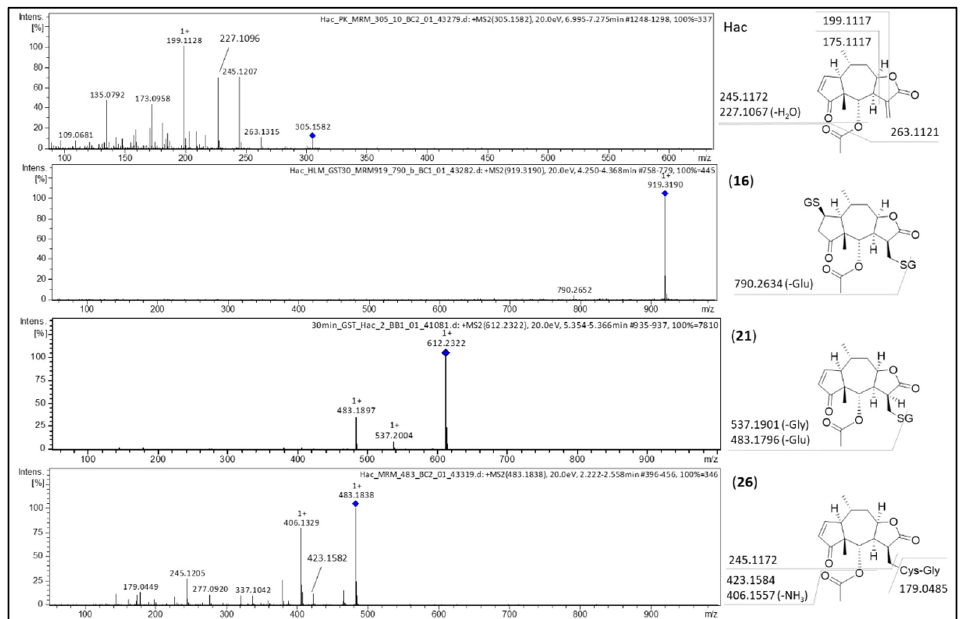
Figure 5. MS/MS spectra of Hac and its most abundant metabolites Hac-(GSH) 2 ( 16 ), Hac-GSH ( 21 ) and Hac-CysGly ( 26 ) with postulated fragmentation sites. At the structural diagrams the calculated m / z values are given.